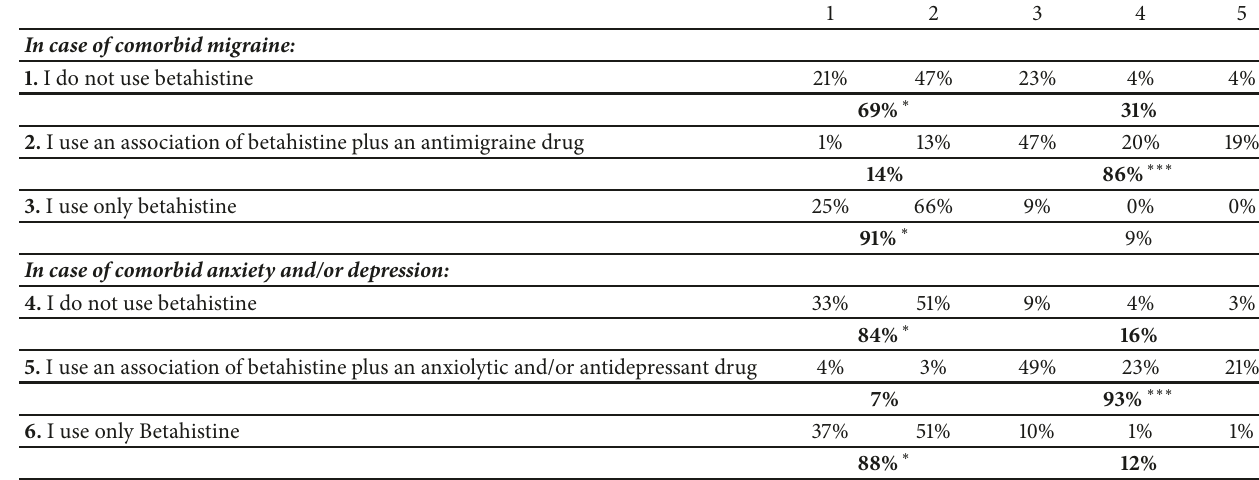
Table 7: Results of the Consensus Conference on the use of betahistine in comorbidity cases. 1 = absolutely disagree, 2 = disagree, 3 = agree, 4 = more than agree, and 5 = absolutely agree. Consensus was reached when the sum of items 1 and 2 or 3, 4, and 5 reached 66%. Same asterisk